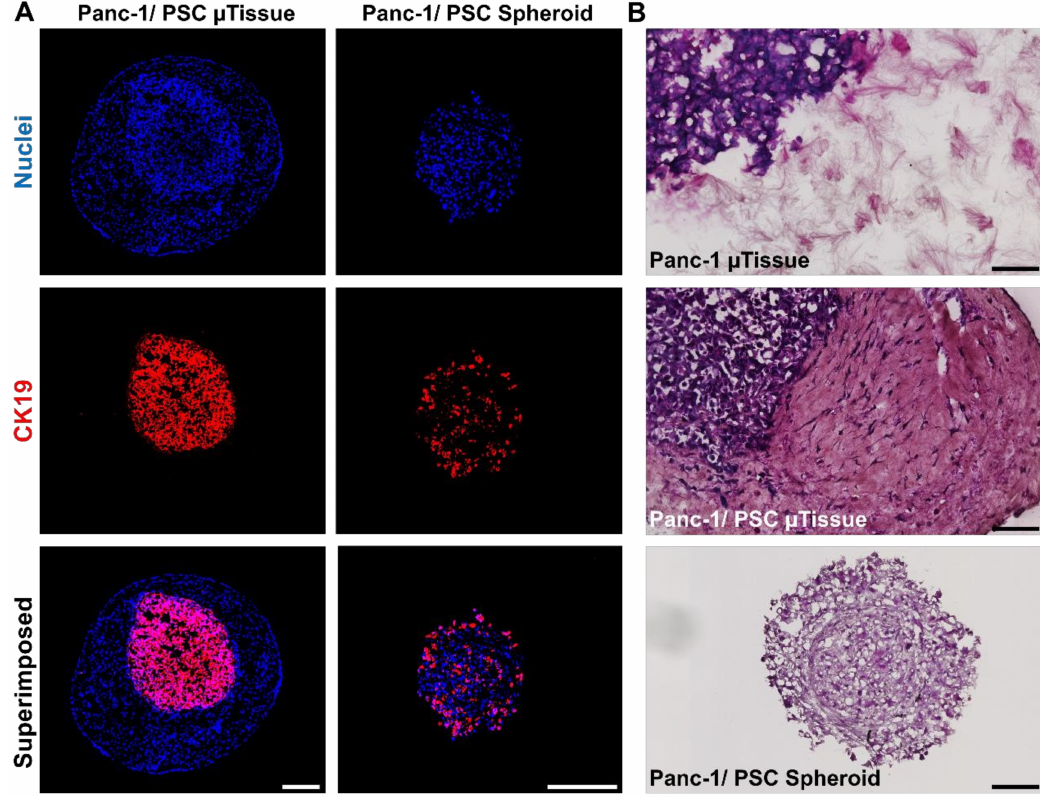
Figure 3. Cellular arrangement of Panc-1/PSC µ tissues. ( A ) Immunofluorescent staining against CK19 (red) and nuclei (blue) for Panc-1/PSC µ tissues and Panc-1/PSC heterospheroids (scale bar = 250 µ m). ( B ) Hematoxylin-Eosin (HE) staining for Panc-1 µ tissues, Panc-1/PSC µ tissues and Panc-1/PSC heterospheroids (scale bar = 100 µ